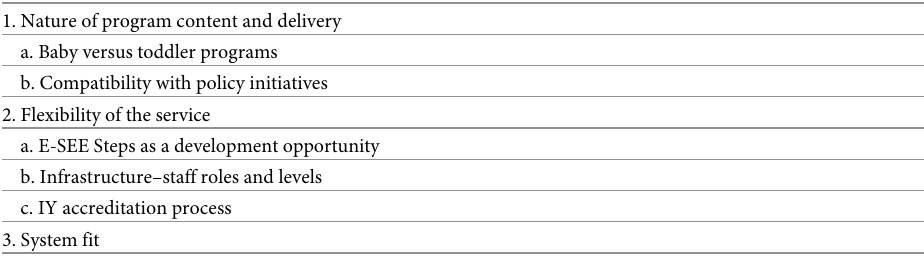
Table 3. Themes and sub-themes related to feasibility of E-SEE